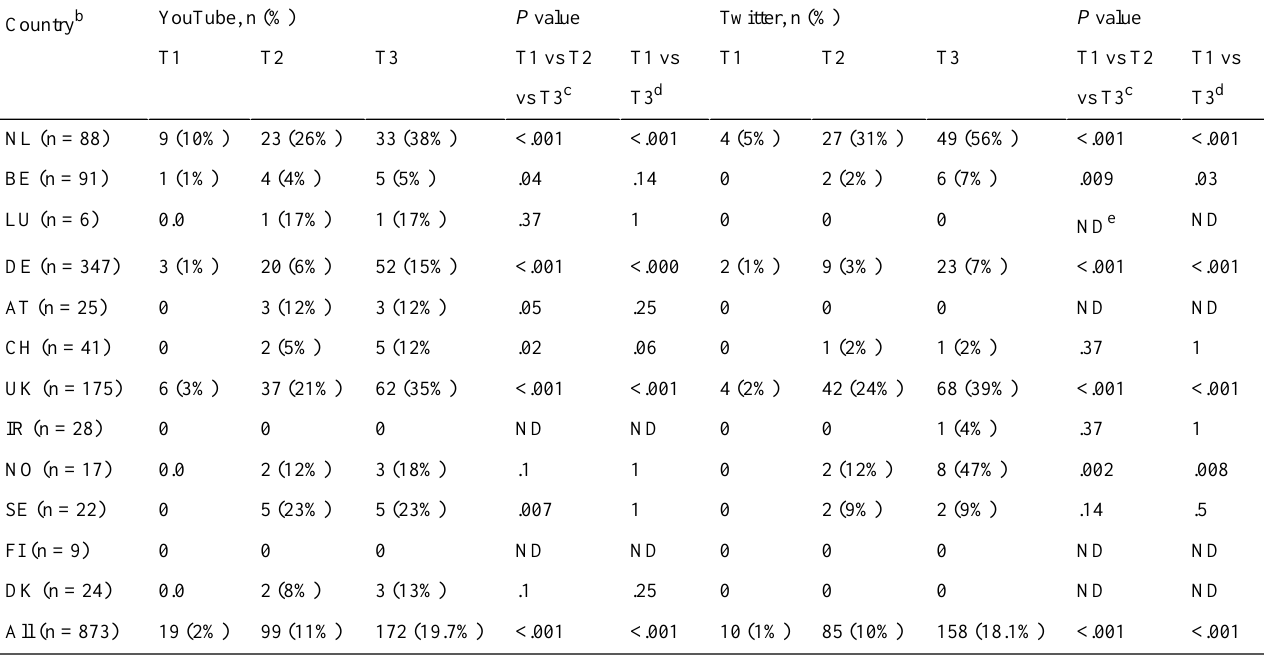
Table 3. Social media usage (T1–T3) a in 12 Western European countries (YouTube and